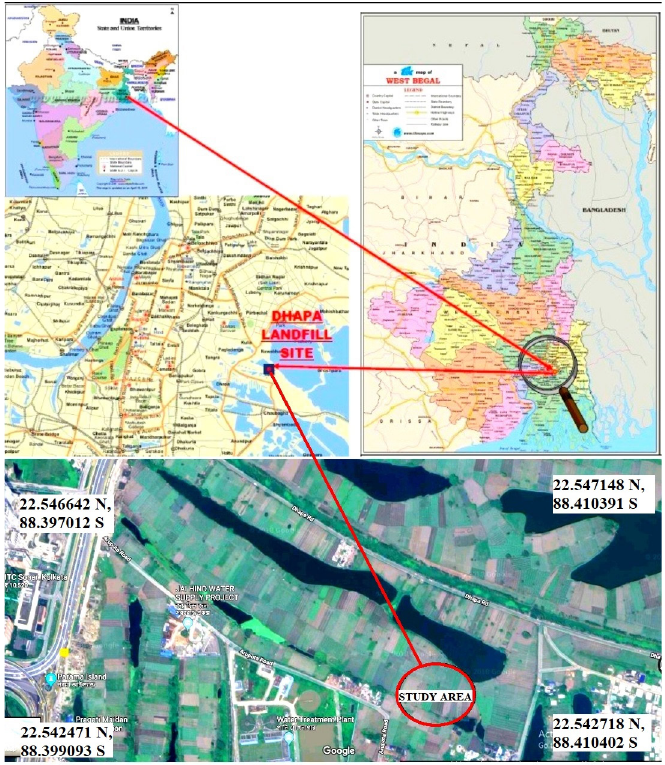
Figure 1. Location map of the study area (Courtesy Google